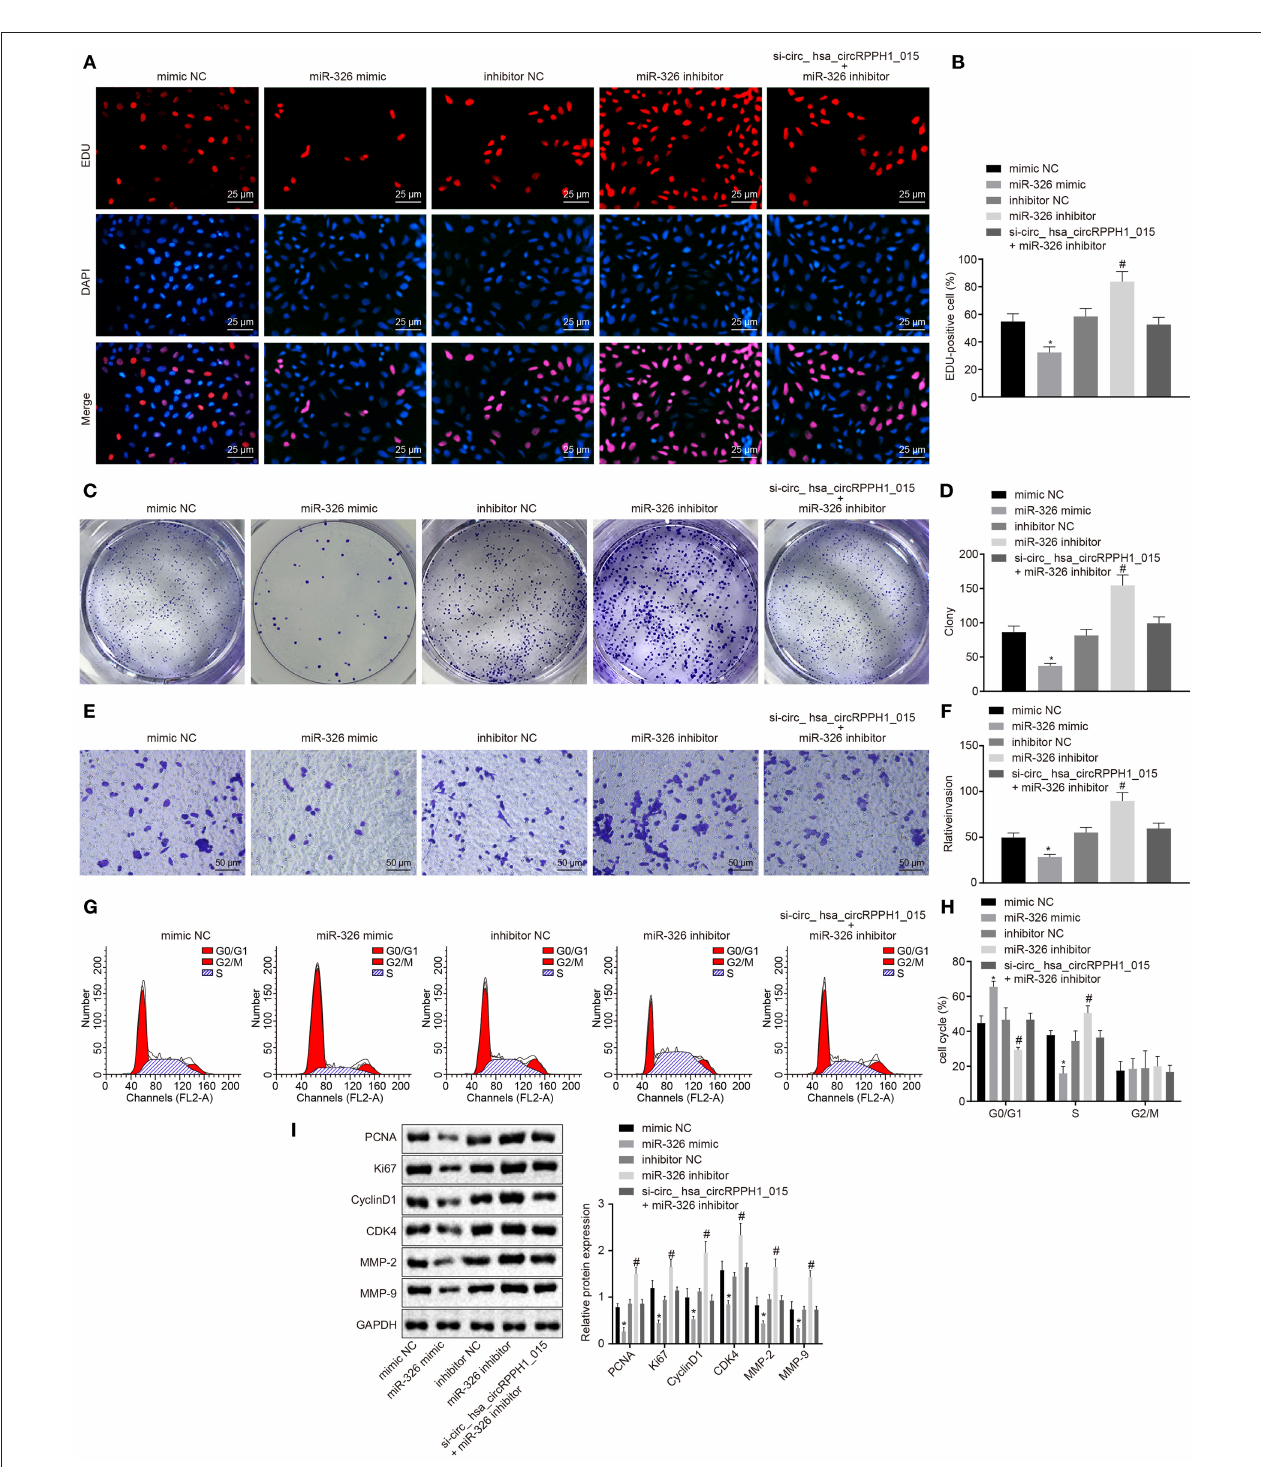
FIGURE 5 | miR-326 inhibited the occurrence and development of BC. (A,B) MCF-7 cells positive staining in each group examined by EdU assay ( × 400). (C,D) Representative images of MCF-7 colony formation and the quantification diagram examined by colony formation assay. (E,F) The invasion ability of MCF-7 cells in each group examined by Transwell assay ( × 200). (G,H) The cell cycle distribution of MCF-7 cells in each group examined by flow cytometry. (I) The relative protein expression of associated proteins normalized to GAPDH in each group determined by Western blot analysis in MCF-7 cells. * p < 0.05 vs. the mimic-NC group (MCF-7 cells transfected with mimic-NC). # p < 0.05 vs. the inhibitor-NC group (MCF-7 cells transfected with inhibitor-NC). The quantitative analysis results were measurement data and analyzed by one-way ANOVA among multiple groups. Values were obtained from three independent experiments. BC, breast cancer;